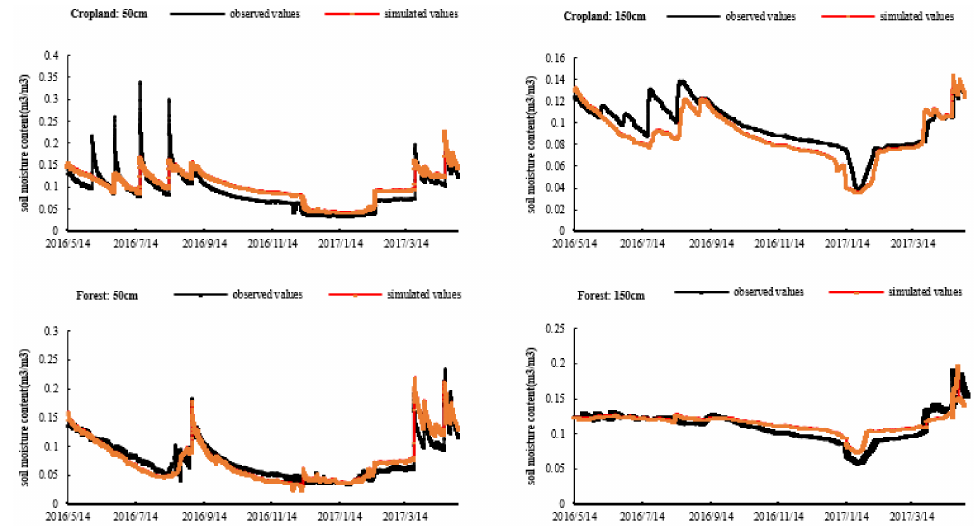
Figure 5. Comparison of simulated and observed soil water content (cropland, forest).